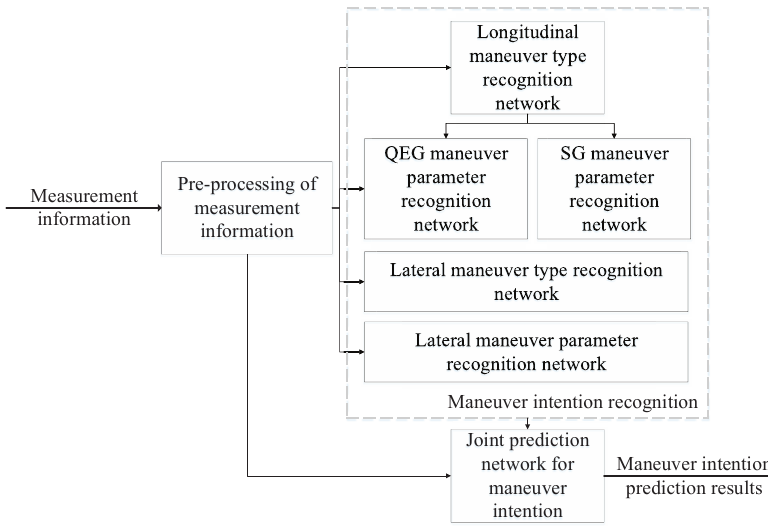
Figure 3. The joint prediction algorithm based on